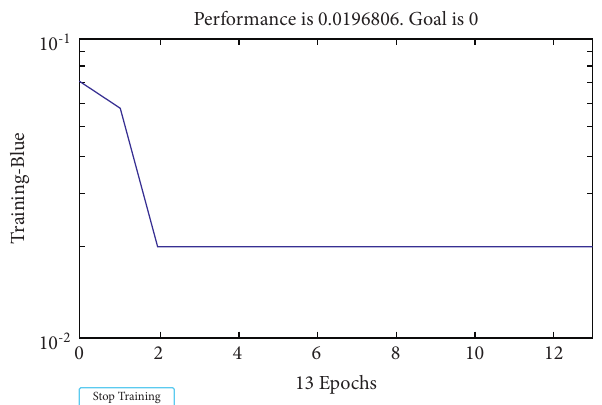
Figure 9: Performance curve for surface roughness